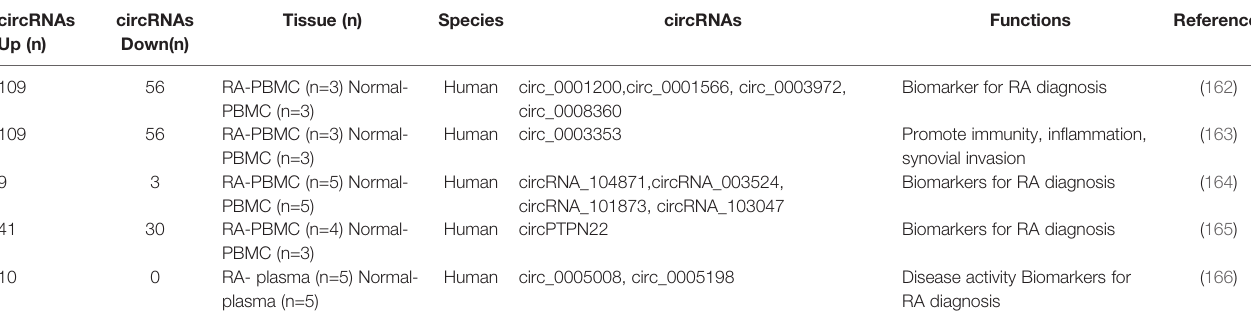
PBMC, Peripheral blood mononuclear cell.